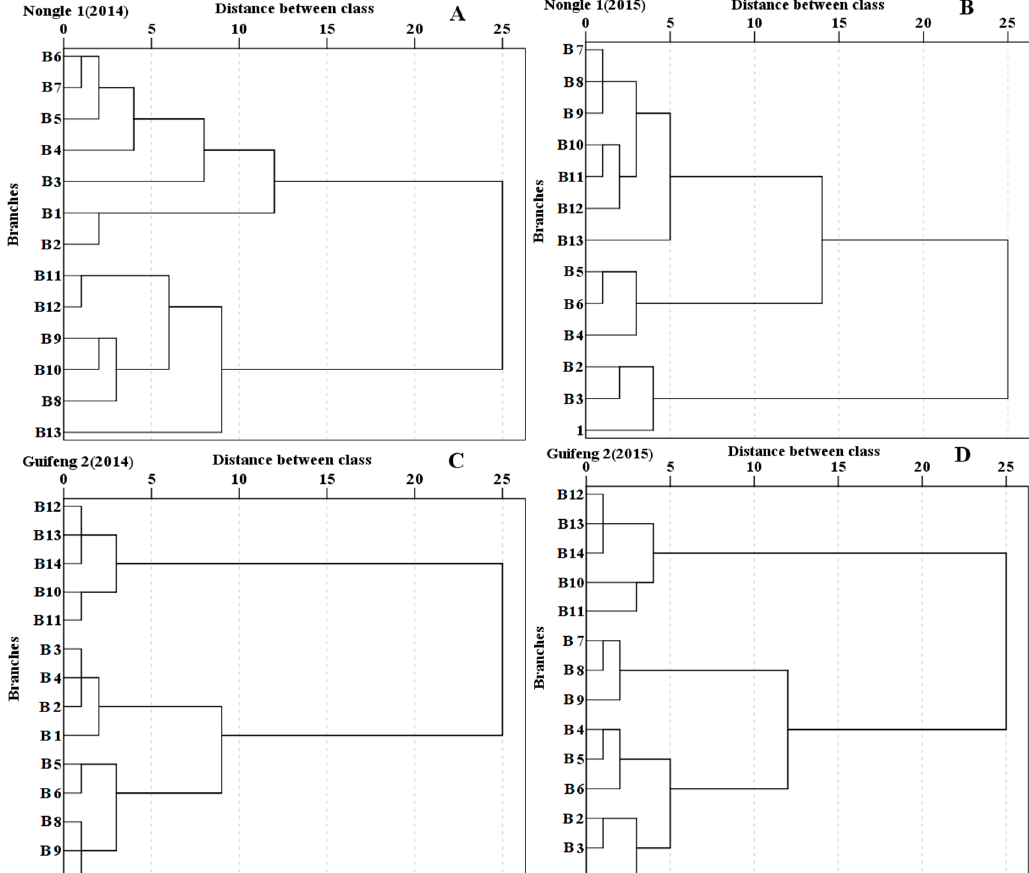
Figure 6. Cluster analysis of all primary-branch grains at different positions for Nongle 1 ( A , B ) and Guifeng 2 ( C , D ) in 2014 and 2015. B1 to B14 represent the 1st primary-branch grains to the 14th primary-branch grains from the top to the base of the panicle for Nongle 1 and Guifeng 2.